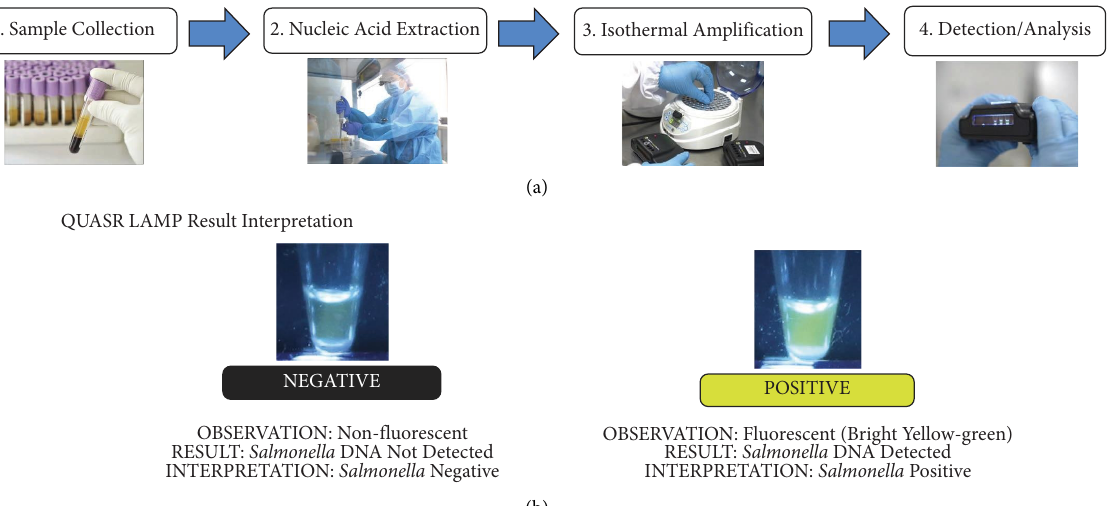
Figure 4: (a) Typical QUASR LAMP workfow in clinical diagnosis setting. Te QUASR LAMP workfow is like the LAMP workfow (Figure 1) without the dye addition step. Not opening the tube after amplifcation makes QUASR LAMP less prone to contamination and false positives. (b) QUASR LAMP interpretation of results. Analysis can be done by viewing the reaction tubes through a blue LED light with a yellow flter. Positives appear bright fuorescent yellow green, and negatives appear nonfuorescent and